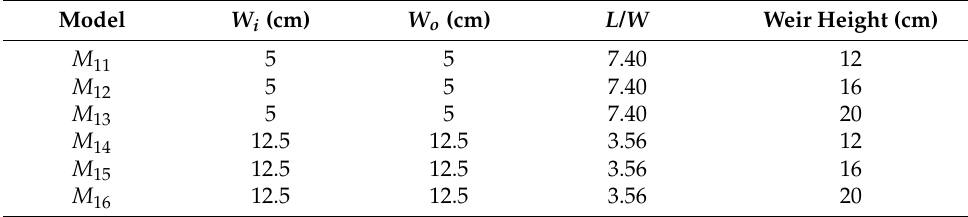
Table 4. First set of dimensions for the six models.